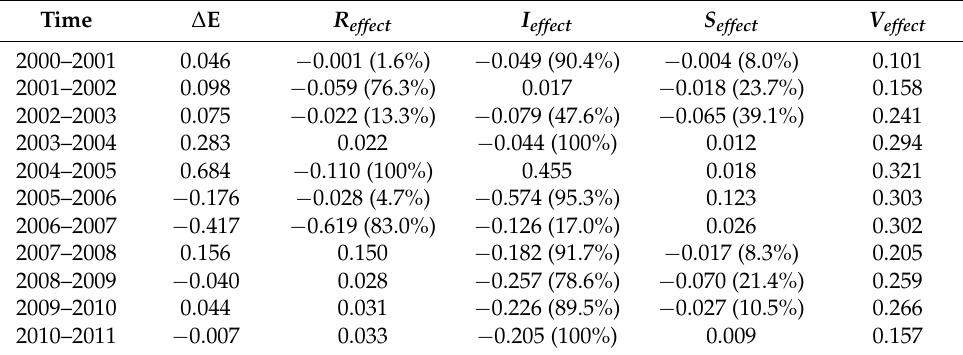
Table 3. Decomposition results of SO 2 emission changes in Jiangsu province (unit: Mt). Time ∆ E